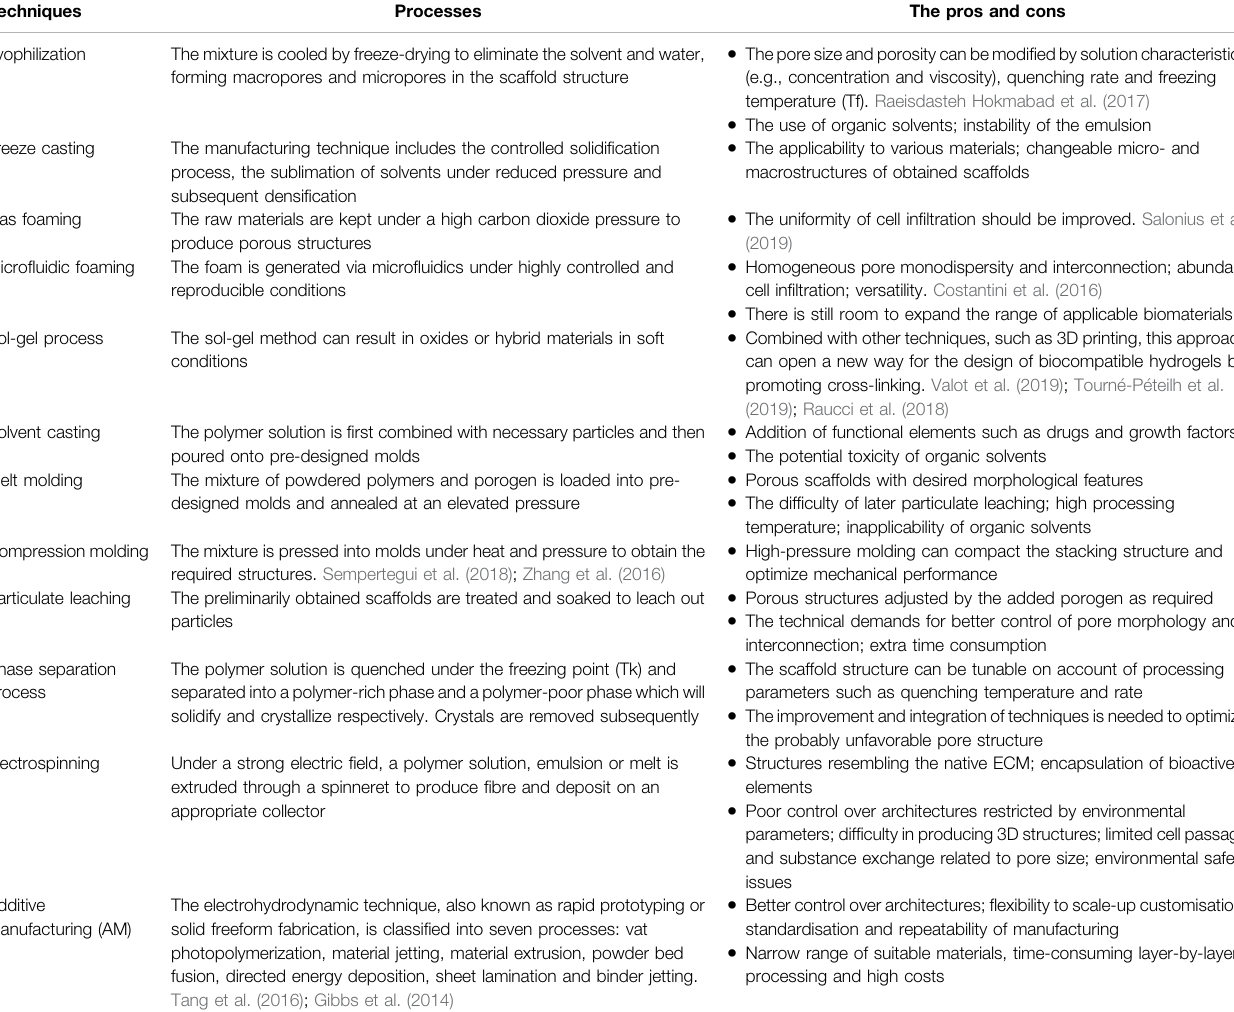
TABLE 2 | Fabrication techniques of scaffolds in osteochondral tissue